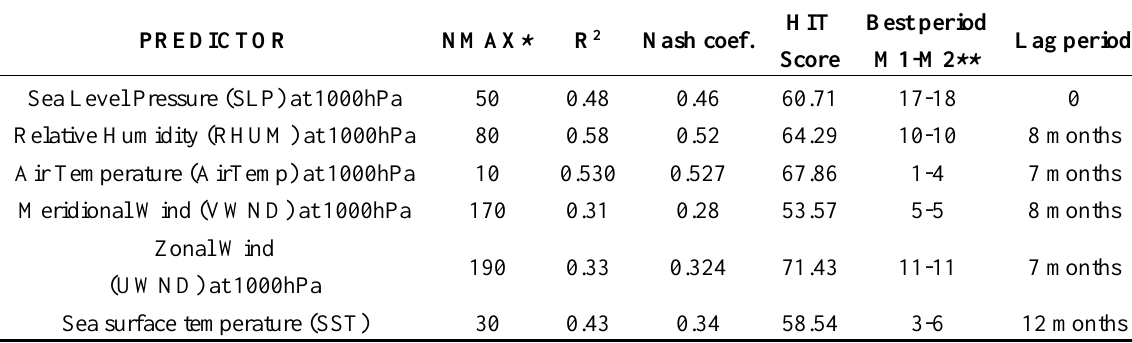
Table 3. Combined linear methods for seasonal rainfall forecast.